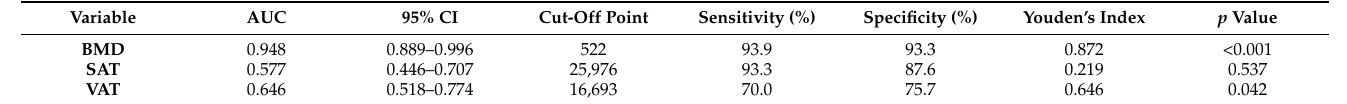
Table 4. Prediction analysis of radiomic parameters of patients with low or high FLIPI Scores.